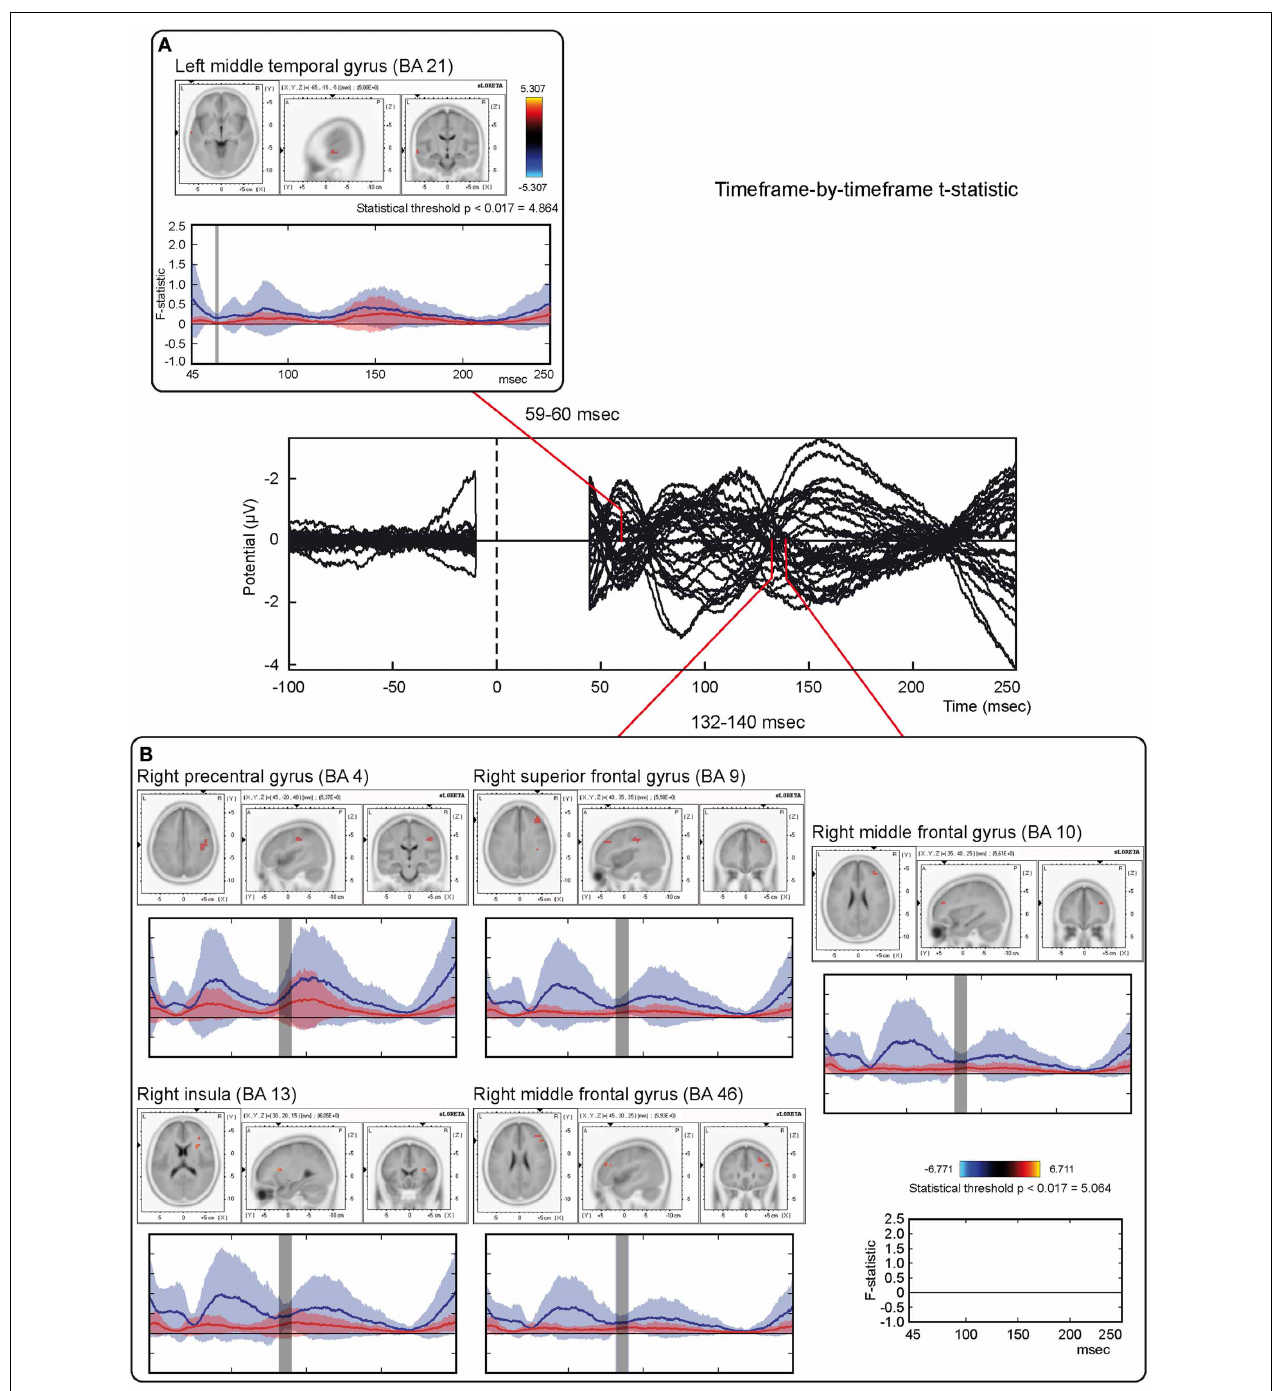
FIGURE 4 | Time-frame by time-frame sLORETA results (1). Principal sLORETA results obtained when considering a time-frame by time-frame analysis performed with t- statistic and comparing real TMS minus sham conditions. Images are plotted with respect to the time windows identified in a butterfly plot of the evoked potentials obtained from the real TMS condition. (A) Results obtained in the 59–60ms time window. Activation with the maximal peak in the left middle temporal gyrus (BA 21) is shown. (B) Results obtained in the 132–140ms time window. Activations with the maximal peaks in the right sensorimotor and frontal regions (BA 4, 9, 10, 13, and 46) are shown. The time course of the intensity of the signal in